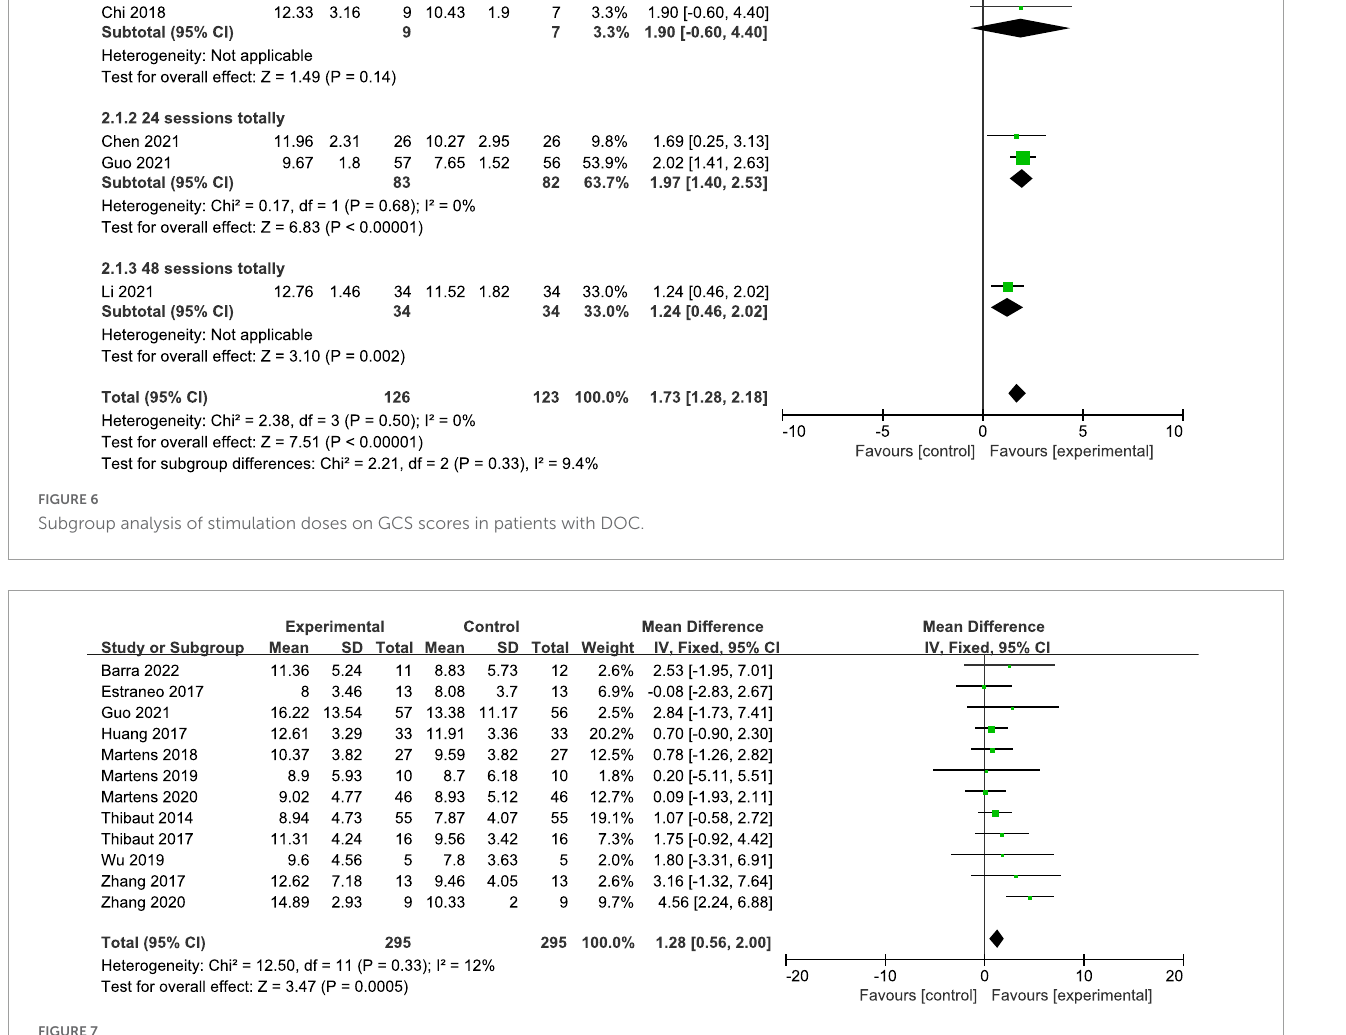
FIGURE7 Meta-analysis of all studies on CRS-R scores in patients with